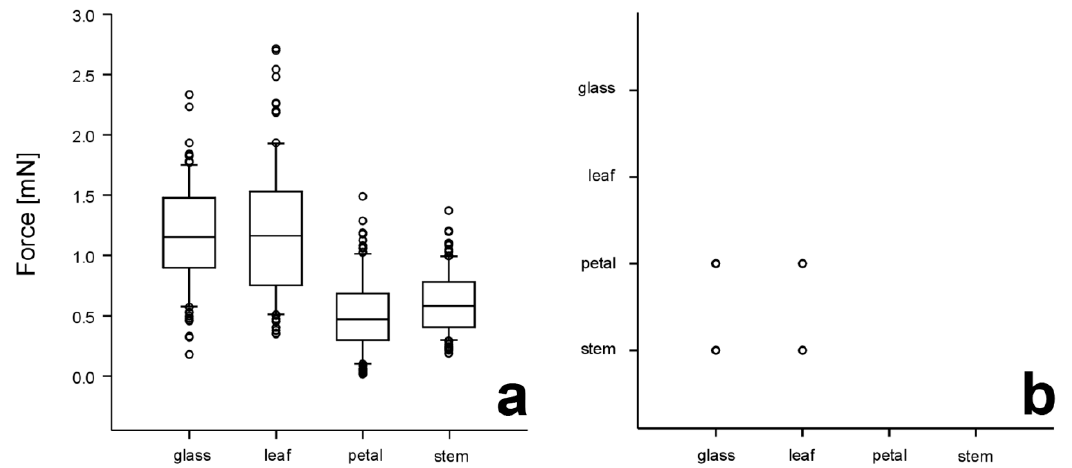
Figure 4. Traction forces produced by flies Eristalis tenax on different substrates (glass, adaxial sides of the upper leaf and the petal, and the stem in the plant Dahlia pinnata ) ( a ) and results of the statistical comparison of the force values obtained on different substrates ( b ). In ( a ), boxplots show the interquartile range and the medians, whiskers indicate the 1.5 × interquartile range, and “ ◦ ” are outliers. In ( b ), circles mean significant differences in force values between substrates at p < 0.05 (Tukey post hoc test, two-way ANOVA).